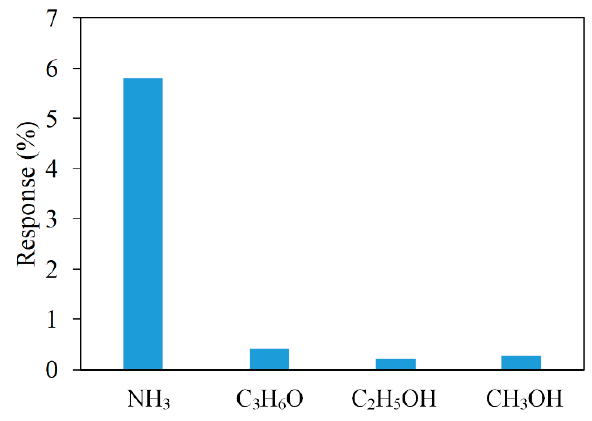
Figure 15. Response of the AGS under different gases.